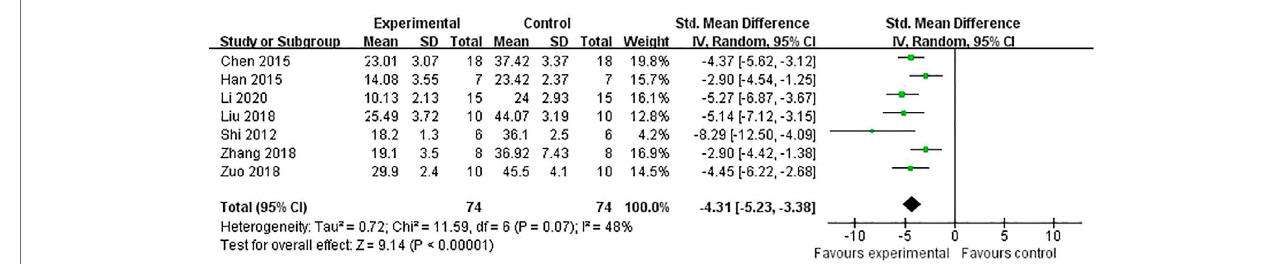
FIGURE 2 | The pooled estimate of RRC for improving infarct volume according to TTC staining.